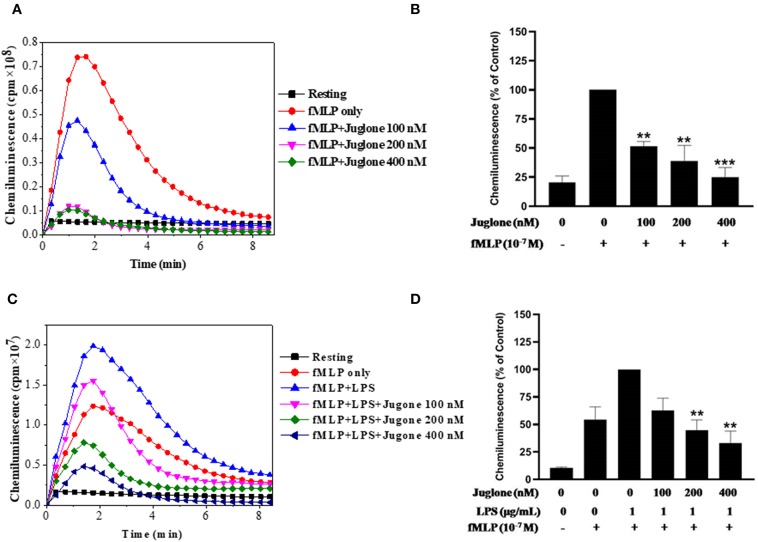
Effect of Juglone, a Pin1 inhibitor on fMLP-induced and LPS-primed ROS production by human neutrophils. (A) Human neutrophils (1 × 106/ml) were incubated in the absence or presence of increasing concentrations of Juglone for 20 min at 37°C, then stimulated with fMLP (10−7 M). ROS production was measured with a luminol-amplified chemiluminescence technique. (B) Total chemiluminescence in each experimental condition is expressed as mean plus or minus SEM of 3 experiments. **p < 0.05 and ***p < 0.001 as compared with fMLP alone (control 100%). (C) Human neutrophils (1 × 106/ml) were incubated in the absence or presence of increasing concentrations of Juglone for 20 min at 37°C, then LPS (1 μg/mL) was added for another 20 min before stimulation with fMLP (10−7 M). ROS production was measured with a luminol-amplified chemiluminescence technique. (D) Total chemiluminescence in each experimental condition is expressed as mean plus or minus SEM of 3 experiments. **p < 0.01 as compared with control (100%).